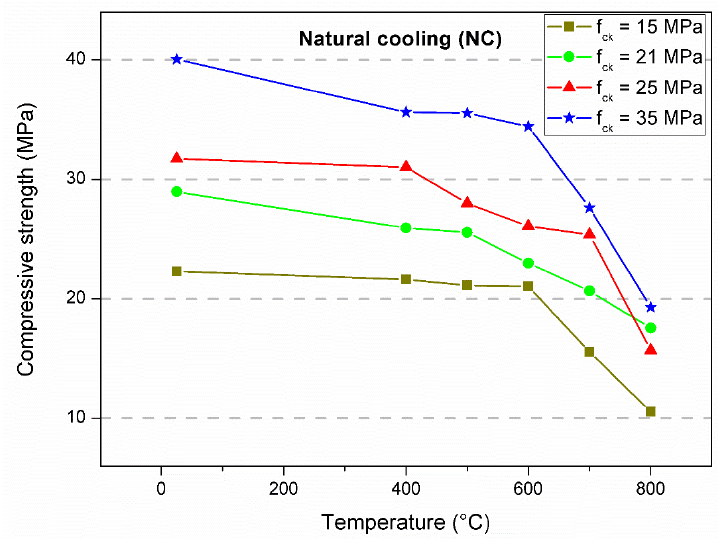
Figure 3. Compressive strength average of specimens cooled naturally. Materials 2019 , 12 , x FOR PEER REVIEW